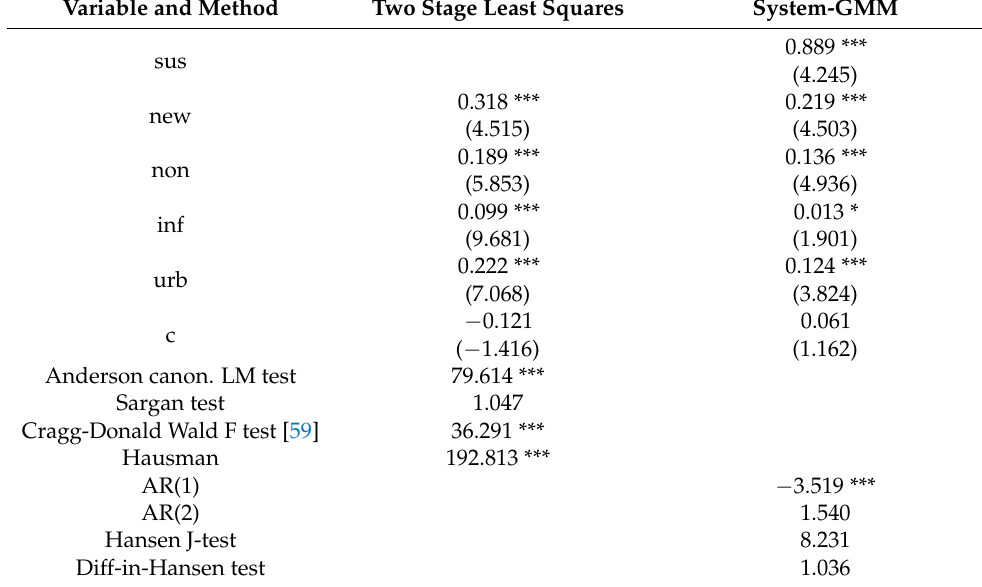
Table 5. Results of robustness